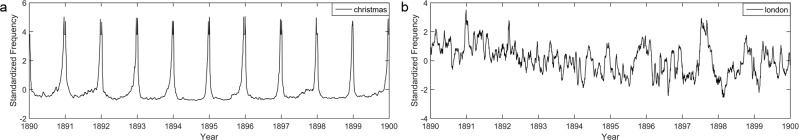
An example of two different word time series as extracted from historical newspapers in the United Kingdom.(a) a time series of a strongly periodic word (Christmas), and (b) a time series which is not periodic (London). Both time series in this example are shortened to the 10 years between 1890 and 1900 for illustrative purposes.